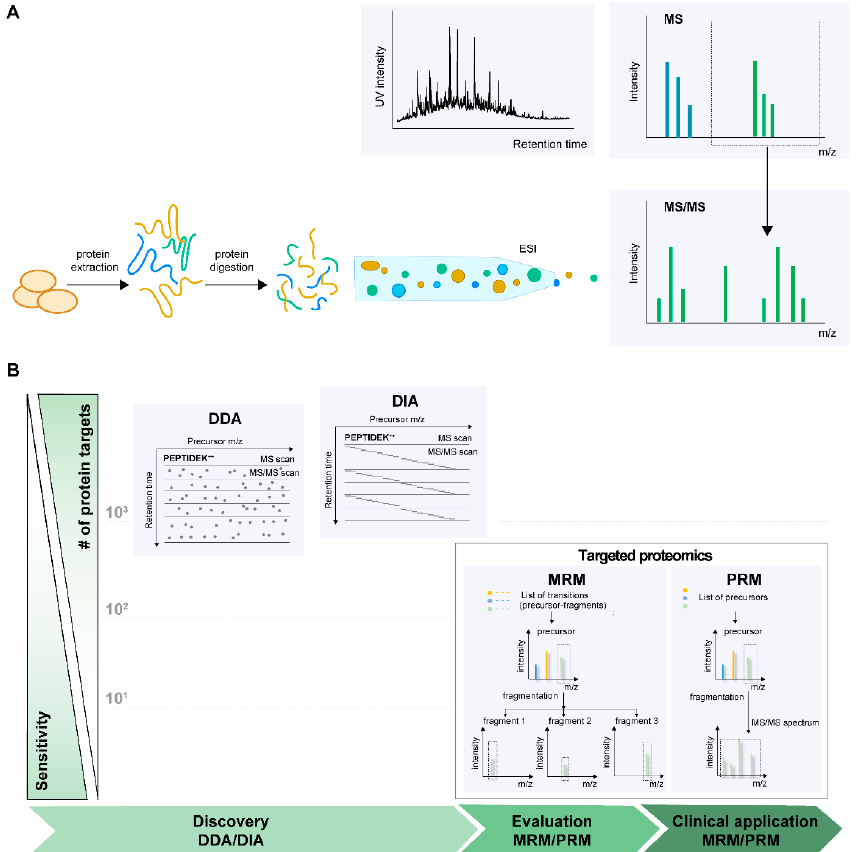
Figure 5. ( A ) LC–MS/MS based bottom-up proteomic workflow. Platelets isolated from blood are subjected to lysis, enzymatic digestion, separation of peptides on a reversed-phase LC column, ionized (ESI), and mass analyzed (MS). ( B ) Modes of MS data acquisition. Three main strategies for data acquisition: data-dependent acquisition (DDA), data- independent acquisition (DIA), and targeted acquisition by multiple or parallel reaction monitoring (MRM or PRM). The DDA and DIA are aimed to analyze global proteomic changes, whereas the targeted methods focused on monitoring preselected target proteins with high precision and